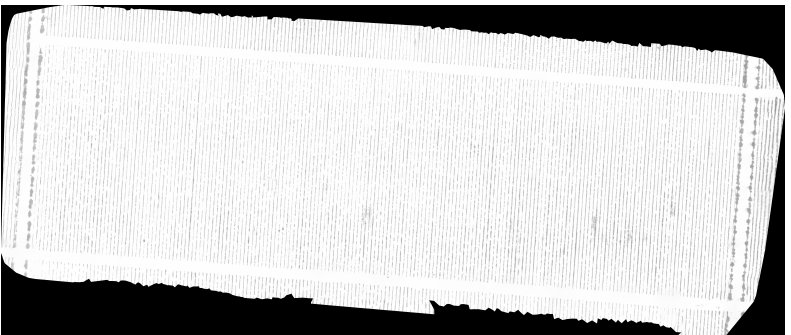
Figure 31. Orthomap generated from thermal images. On average, a distance of 0.01 m is present between two consecutive points.